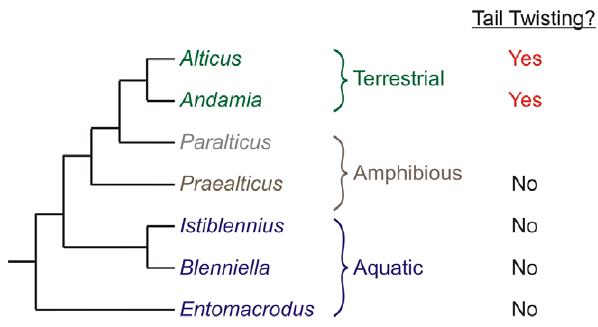
Figure 1. Tail twisting capability and ecological groupings of blenny genera examined in this study. Field observations showed that Alticus and Andamia are on land during both low and high tide. In contrast, Paralticus [35] and Praealticus exit the water infrequently during low tide ( pers. observ. ). Istiblennius, Blenniella , and Entomacrodus all are fully aquatic in their habits and only periodically emerge from water, despite being capable of breathing air. Tail twisting behavior in Paralticus is unknown because individuals were not available for examination. The phylogeny used here was obtained from Spring and Williams